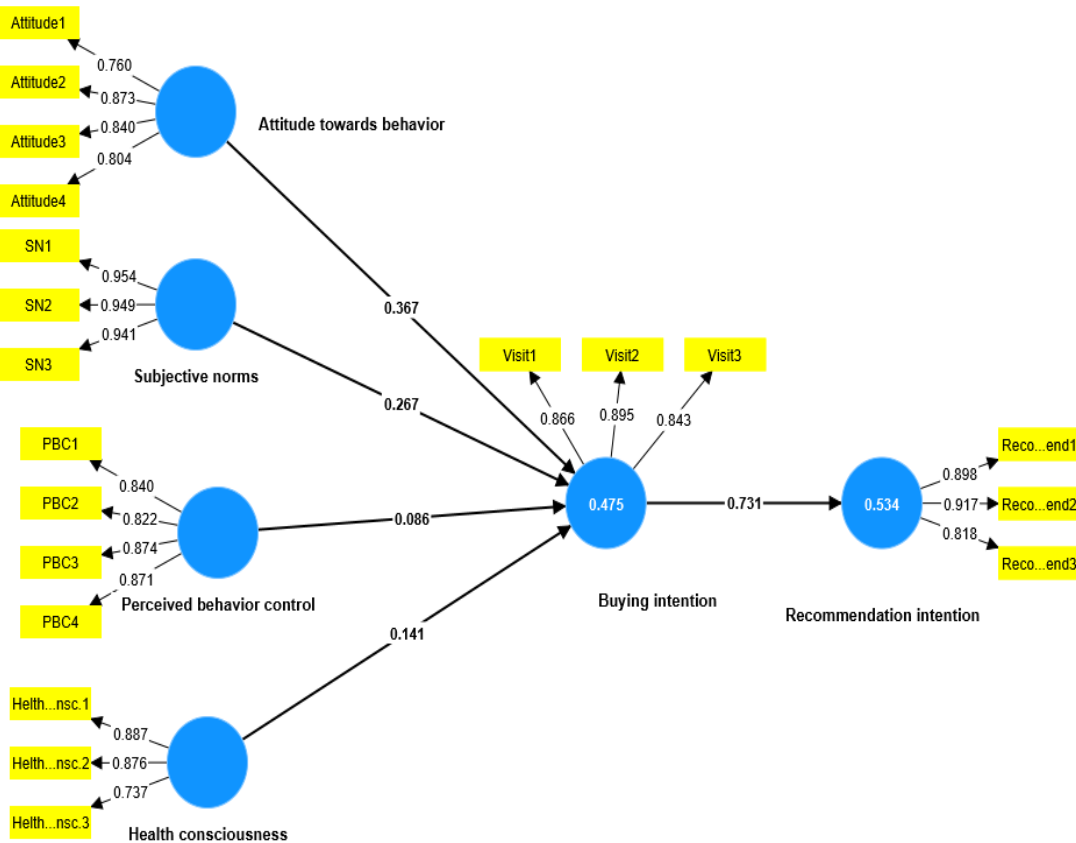
Figure 2. KSA research Model.